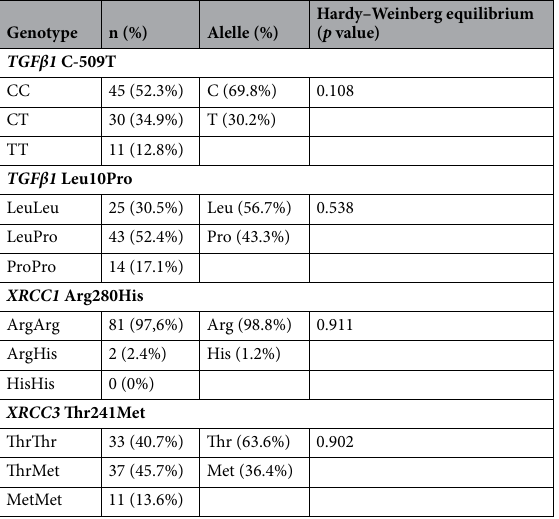
Table 2. The distributions of genotypes and alleles of investigated SNPs in prostate cancer patients. n- Number of